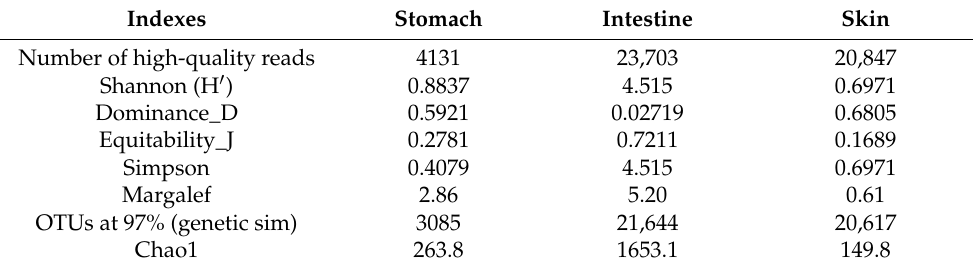
Table 3. Sequencing information, diversity index (H (cid:48) ) and estimator of richness (Chao1 and ACE) obtained after Illumina